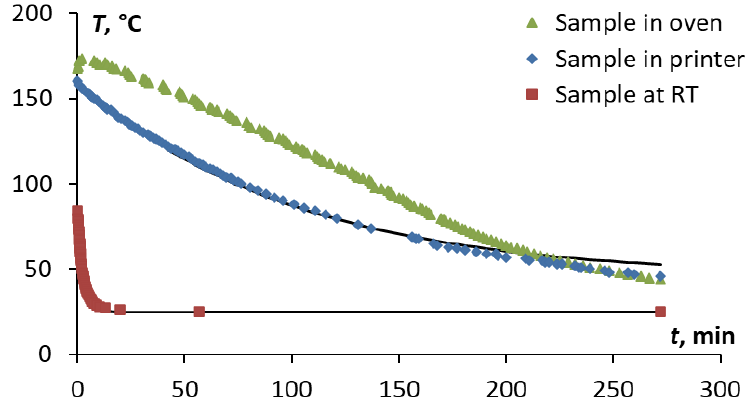
Figure 5. Temperature evolution in Ultem sample vs. time during the cooling process in the printer, oven, and at RT (as indicated on the graph). Symbols are experimental data, lines — evaluation by Equation (1).